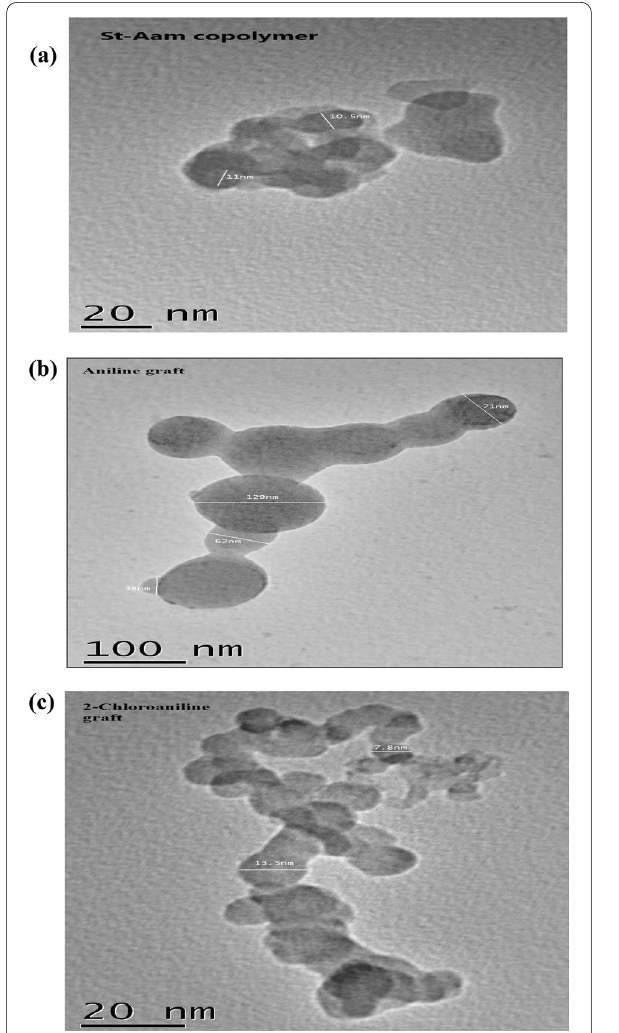
Fig. 4 TEM images of a copolymer, b aniline graft and c 2‑chloroaniline graft